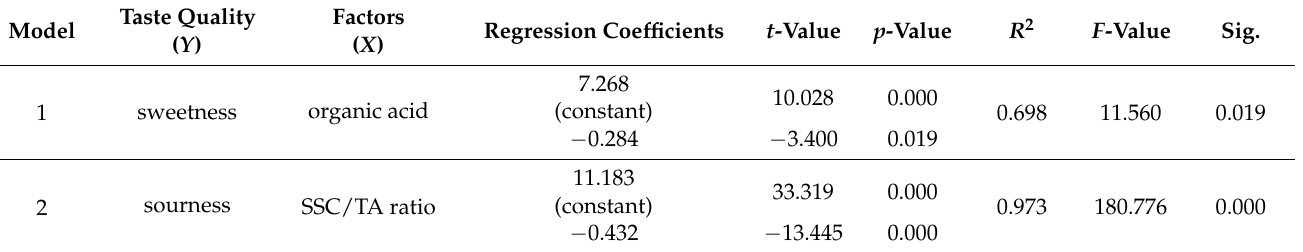
Table 5. Stepwise multiple regression analysis on the key factors of the physicochemical characteristics and viable counts significantly influencing taste qualities of the fermented orange juices and original orange juice